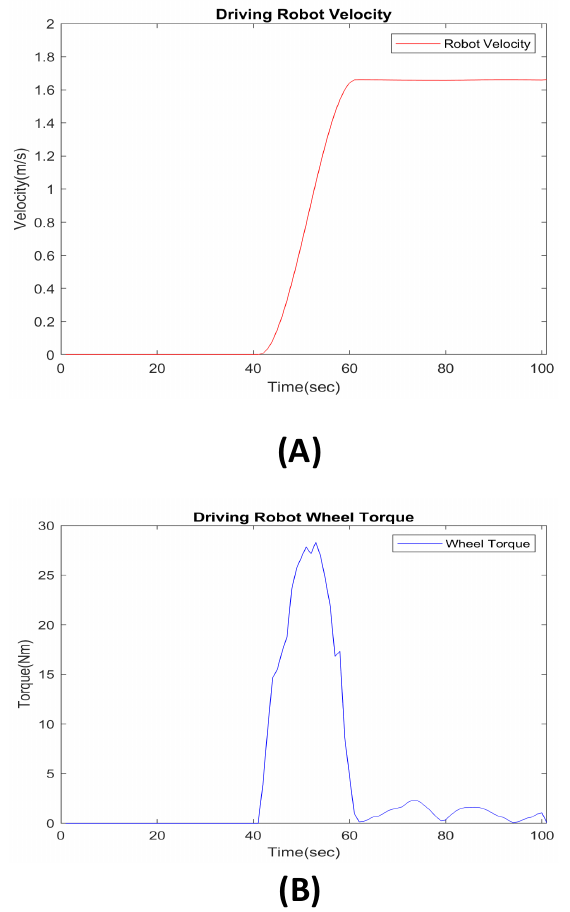
Figure 13. Driving CAE analysis result data. The CAE results show wheel torque and the angular velocity value for following user walking speed (1.6 m/s). ( A ) System velocity. ( B ) System wheel torque